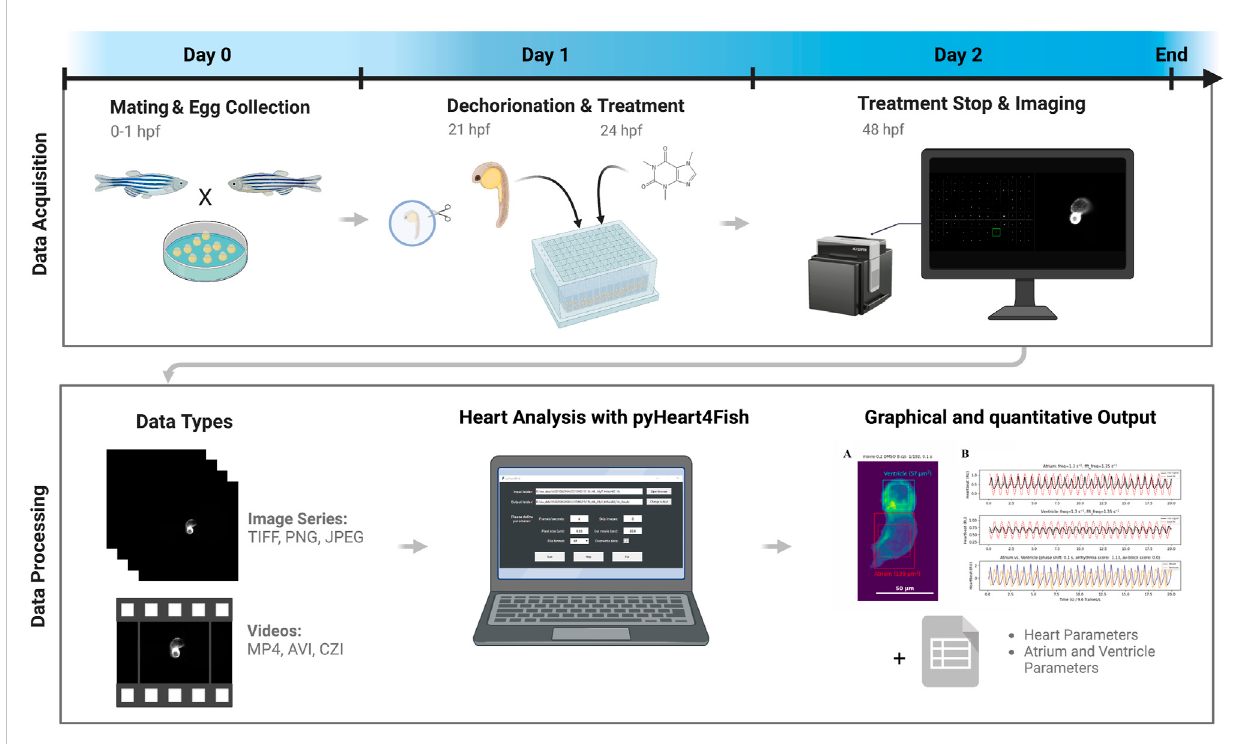
FIGURE 2 Screening and data analysis work fl ow. Eggs were collected after 1 h of pair- or group-wise mating before being incubated overnight. At 21 h post- fertilization (hpf), embryos were dechorionated, then at 24 hpf were treated with compounds from the Prestwick drug library. Treatment was stopped at 48hpf,and fi sh weremounted inorientation plates to visualize fl uorescentheartsand imagedwith an ACQUIFER imaging machine.Displayeddata types can be quanti fi ed using the pyHeart4Fish GUI and result in a graphical output in the form of GIFs and PNGs, as well as data sheets with additional meta and quantitative data. This fi gure was created with